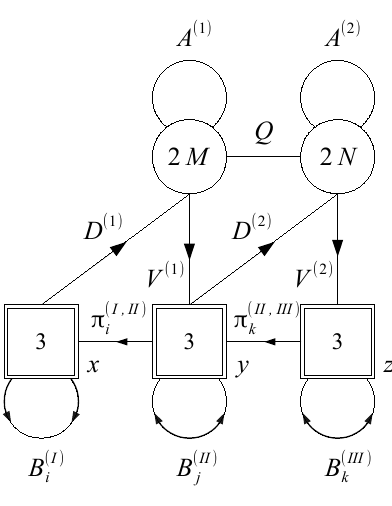
and π ( I,III ) for i = 1 , . . . , M and k = 1 , . . . , N have i k